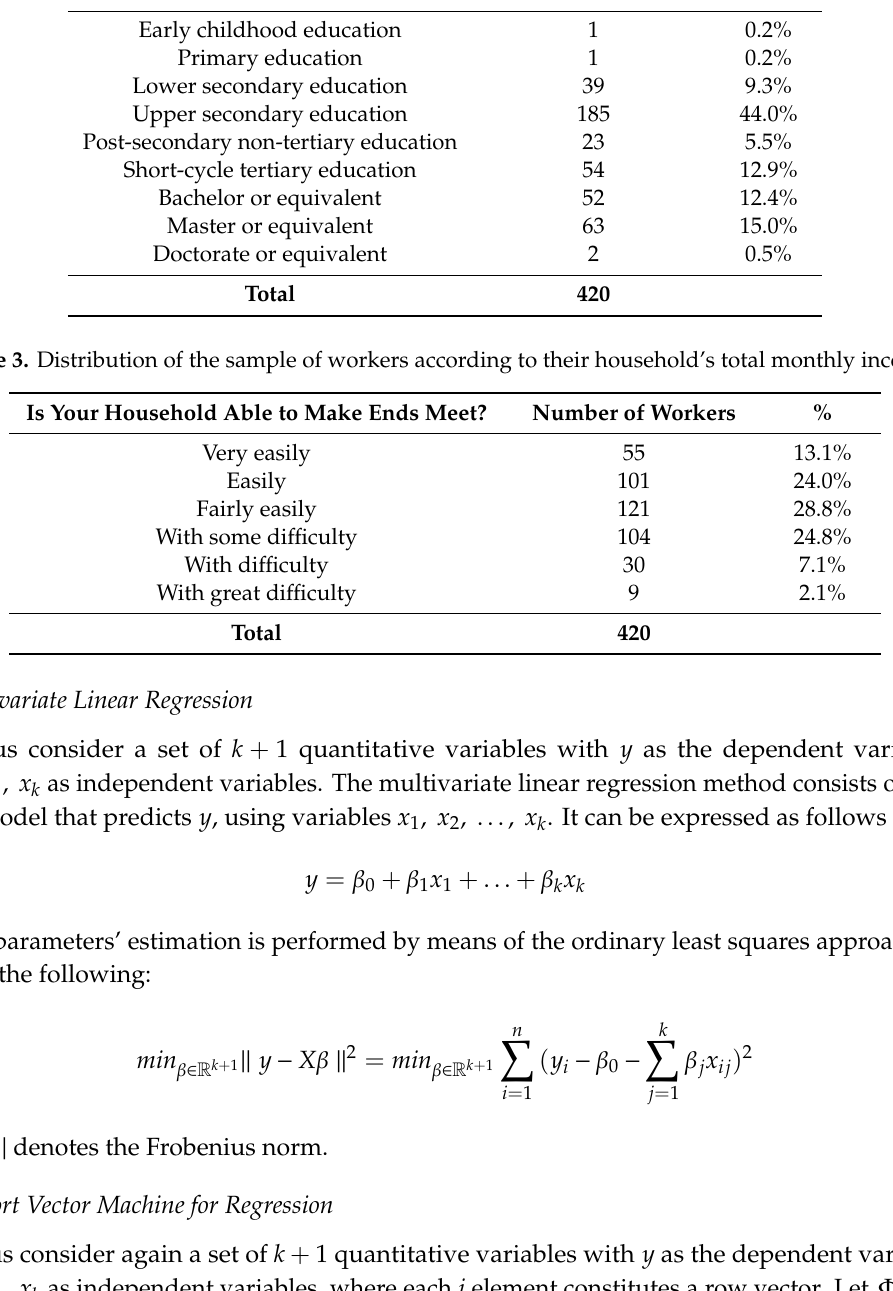
Table 2. Distribution of the sample of workers according to the level of studies (ISCED). Level of Studies (ISCED) Number of Workers % Early childhood education